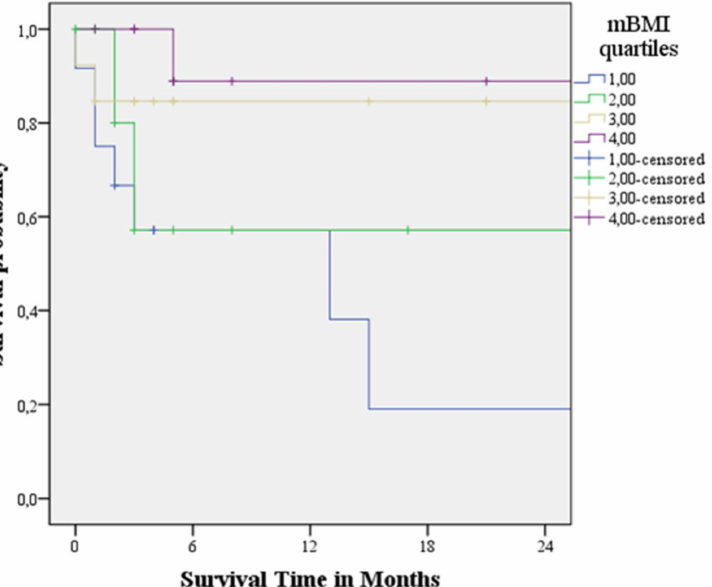
Figure 1. Kaplan-Meier survival curve analysis of cardiovascular mortality in the overall population across the quartiles of the modified Body Mass Index.